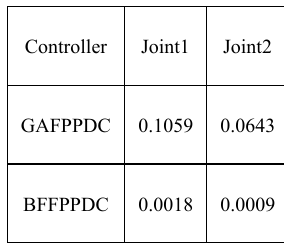
Table 2. Integral square errors for various